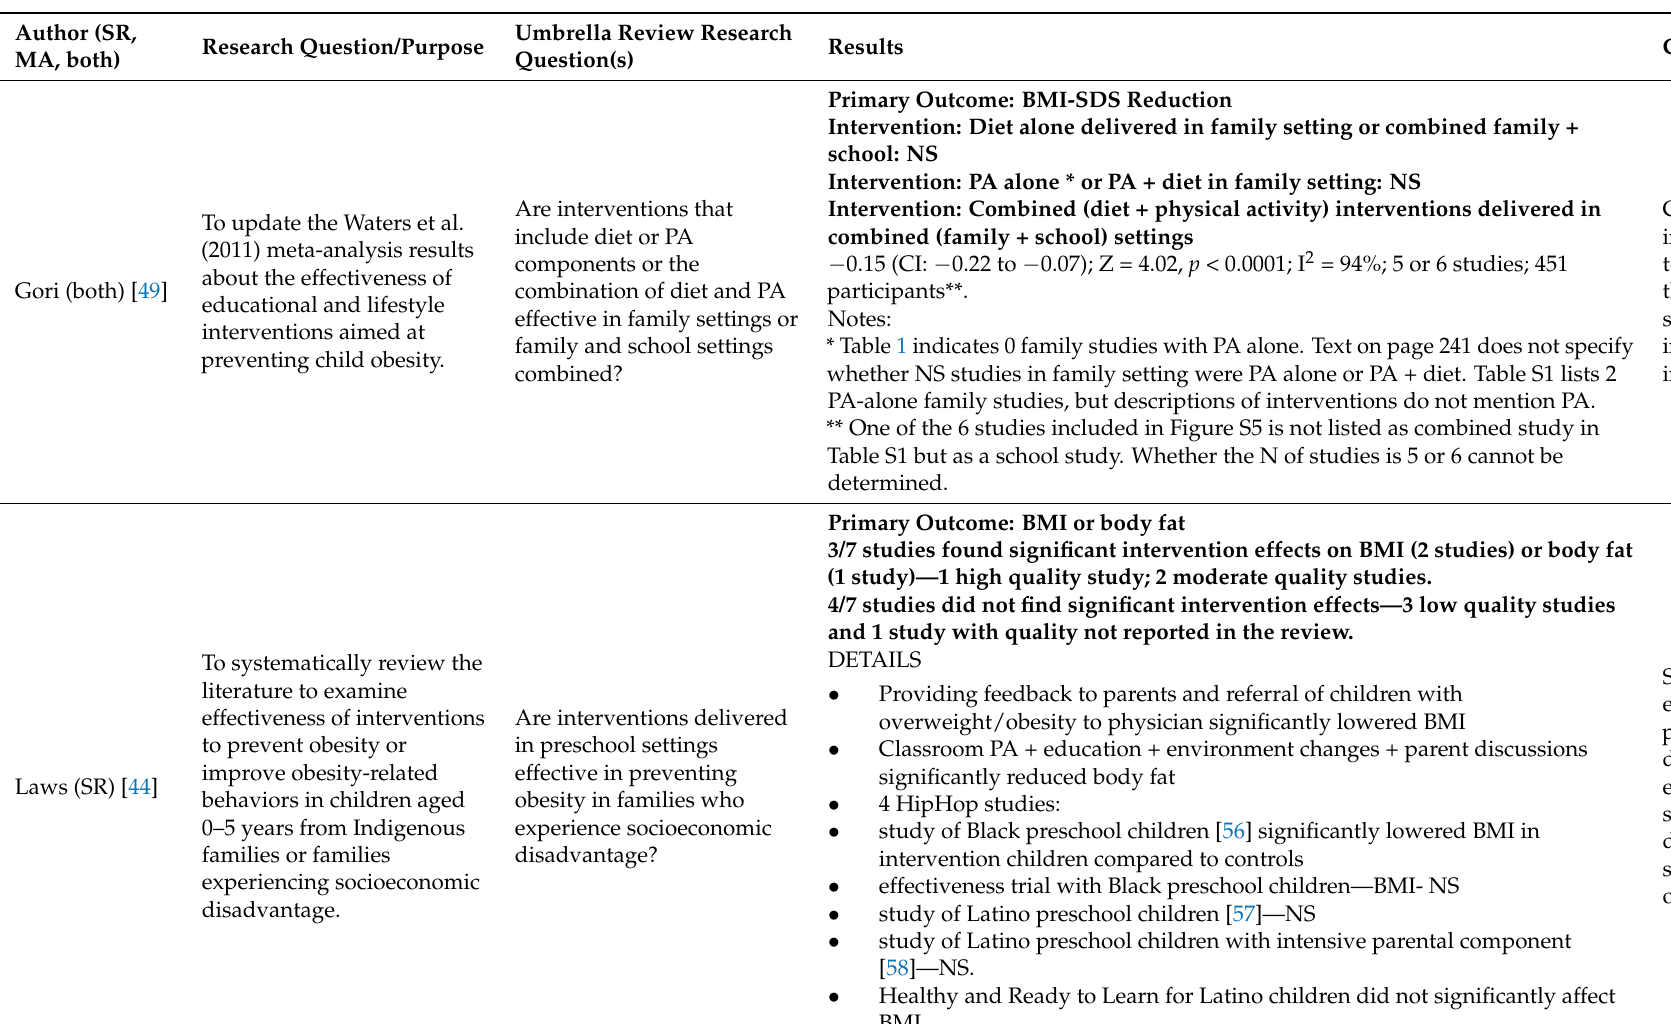
Table 4. Research Questions and Results for SRs/MAs of Prevention